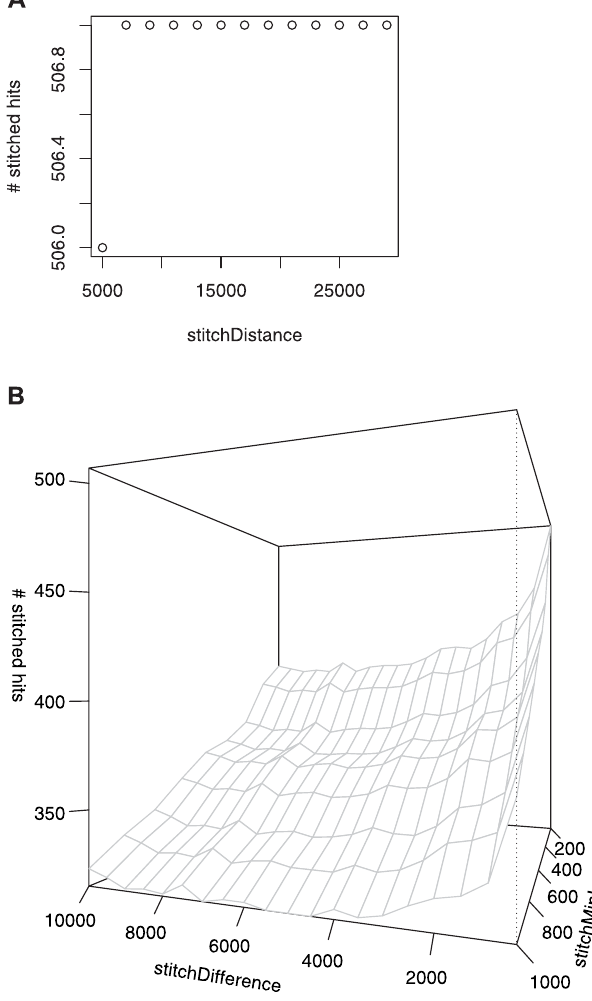
Figure 8. Number of Stitched Hits as a Function of the Parameters stitchDifference, stitchDistance, and stitchMinLen The hits were obtained by locally aligning inter-KIS genomic regions against the other genome in the comparison of the bacteria S. flexneri 2457t versus S. typhi ty2. (A) The number of stitched hits as a function of stitchDistance when stitchDifference ¼ 500 and stitchMinLen ¼ 200. Notice that the number of stitched hits changes only by 1 while stitchDistance ranges from 5,000 to 29,000. This indicates that the value of stitchDistance has a very weak effect on the number of stitched hits. (B) The number of stitched hits as a function of stitchDifference and stitchMinLen when stitchDistance ¼ 29,000. Here, the number of stitched hits decreases rapidly as stitchDifference increases from 1,000 to 2,000. This is followed by a moderate decrease. As stitchDifference approaches 8,000, a moderate increase is observed. The reasons for this increase are similar to those discussed in Tuning the Parameters to explain the increase observed in Figure 7. On the other hand, and as is expected, the number of stitched hits decreases monotonically when stitchMinLen runs from 200 to 1,000. DOI: 10.1371/journal.pcbi.0020075.g008